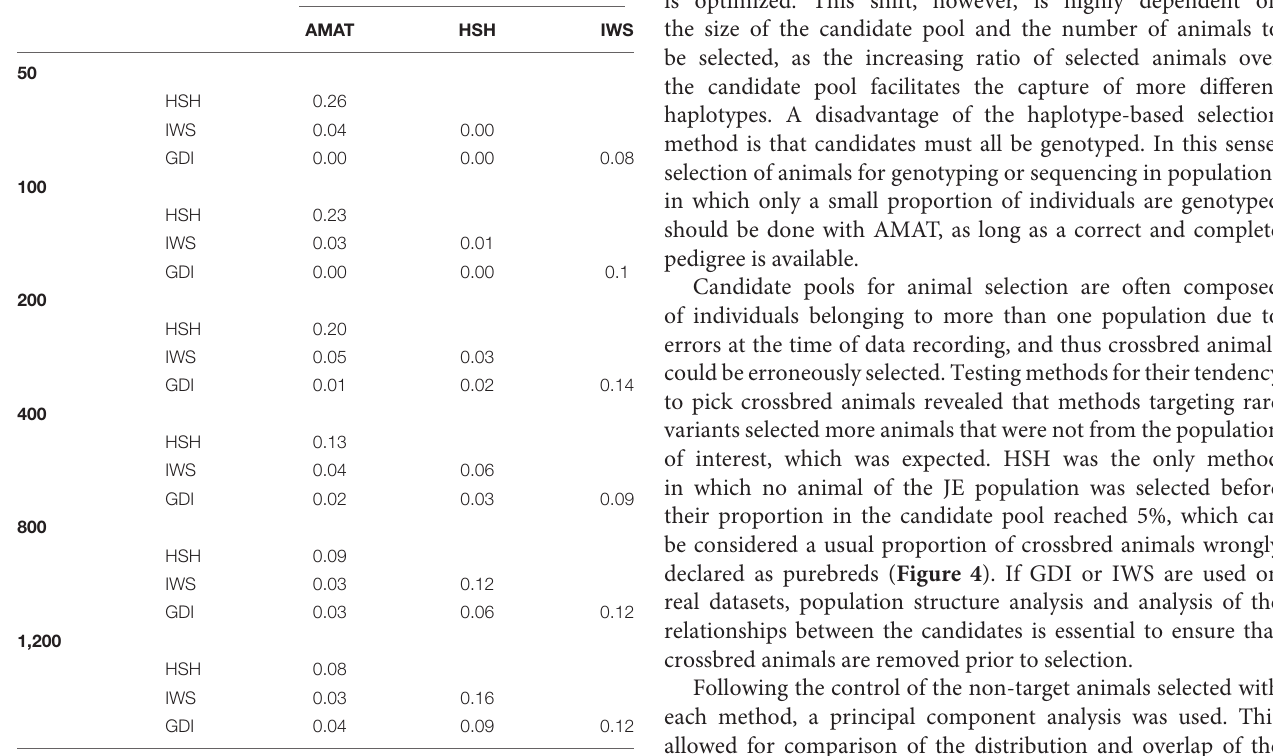
TABLE 3 | Proportion of animals overlapping between selection methods in reference populations of different sizes.